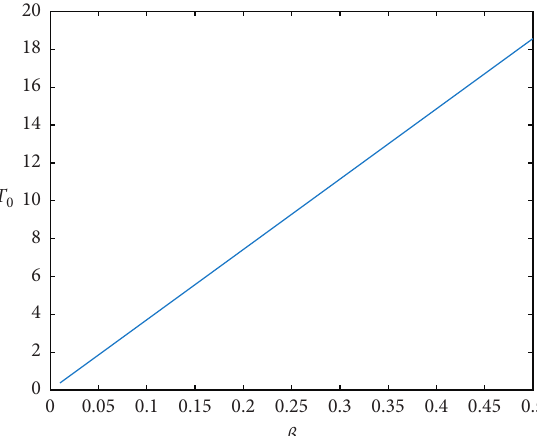
Figure 5: Stability of the attacked solution E